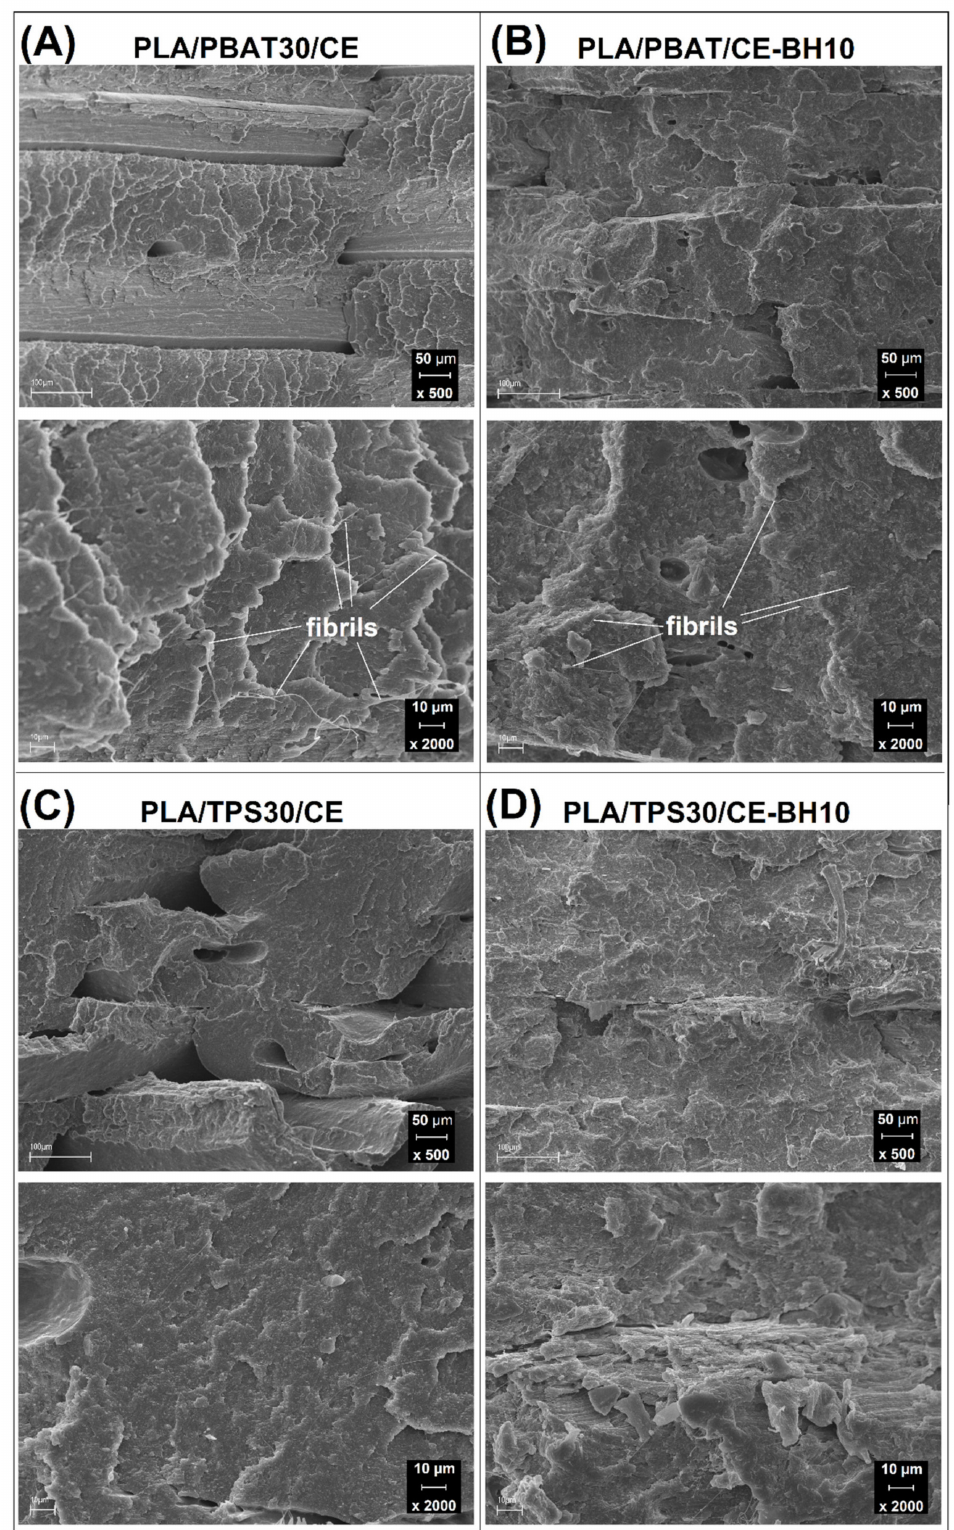
Figure 16. The SEM pictures presenting the structure of FDM-printed samples: ( A ) PLA/PBAT30/CE, ( B ) PLA/PBAT30/CE-BH10, ( C ) PLA/TPS30/CE, and ( D )